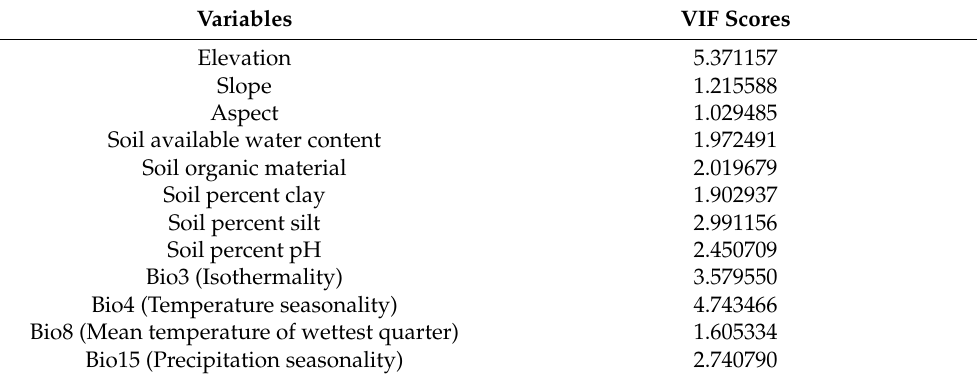
Table 1. VIFs of the 12 variables that remain after elimination based on Pearson’s r and VIF scores.